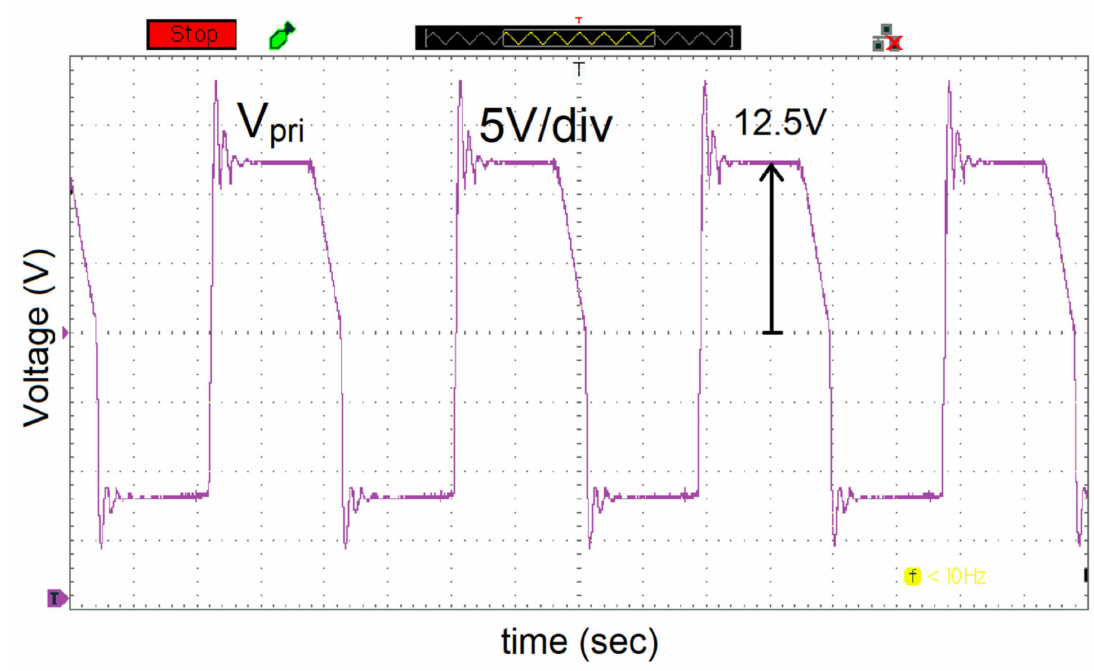
Figure 22. Output voltage of H-bridge and input to high-frequency